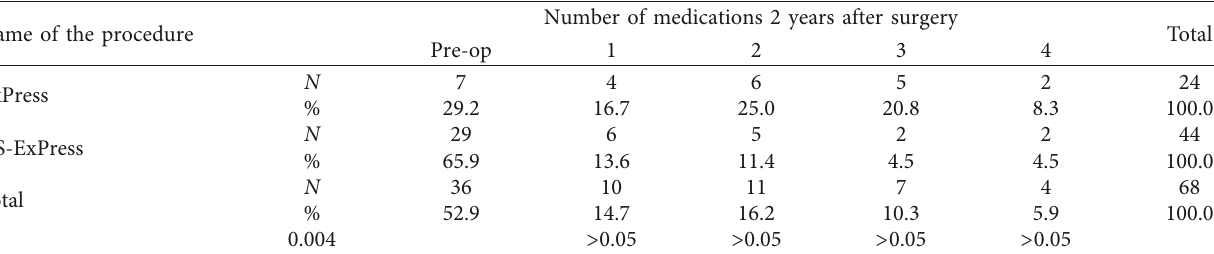
Table 5: Amount of hypotensive drugs in the Ex-Press device implantation (ExPress) and Mermoud’s ExPress modification (DS-ExPress) groups at 2 years after